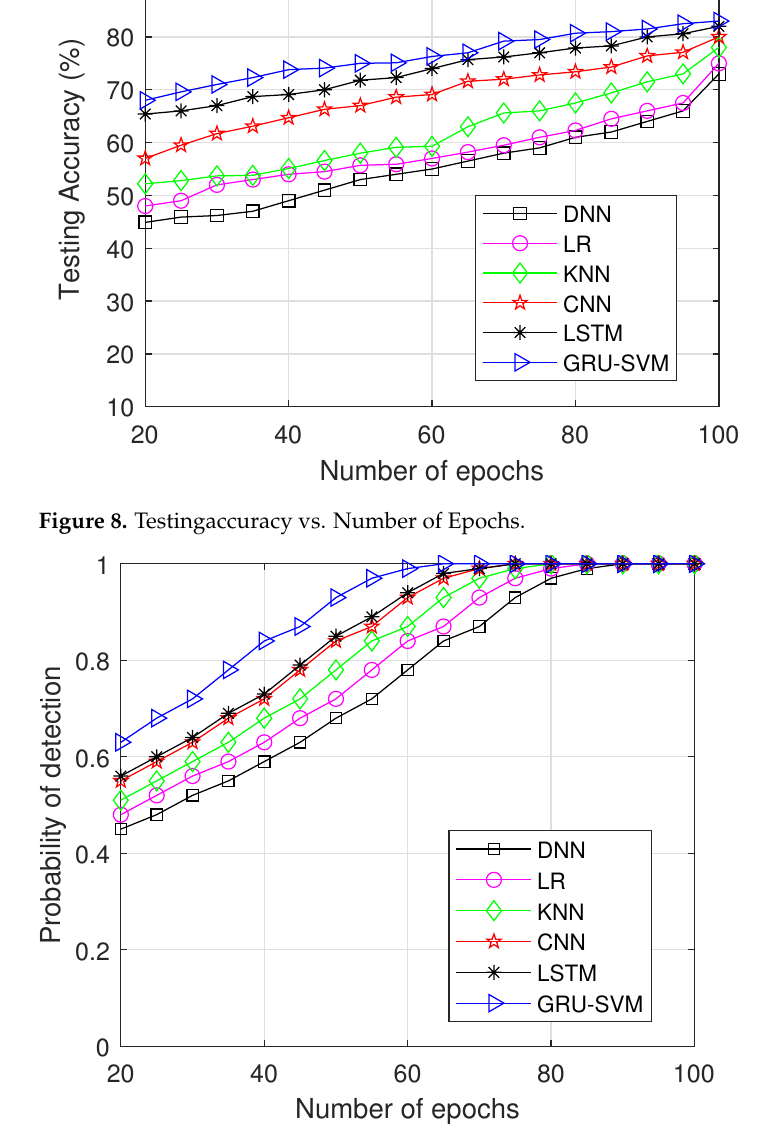
Figure 9. Probabilityof detection vs. Number of Epochs. The probability of false alarm is plotted against the number of epochs in Figure 10, where the proposed model performs well since it has the lowest false alarm probability across all attempted epochs. At 97 epochs, the false alarm probability got reduced to 0 (reaches minimum) compared to other compared methods, which shows better